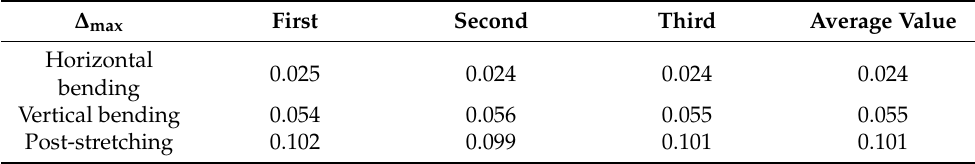
Table 7. The thickness measurement results of the outer web of experiment N3μ s 1δ pre 2δ po 2. Δ max